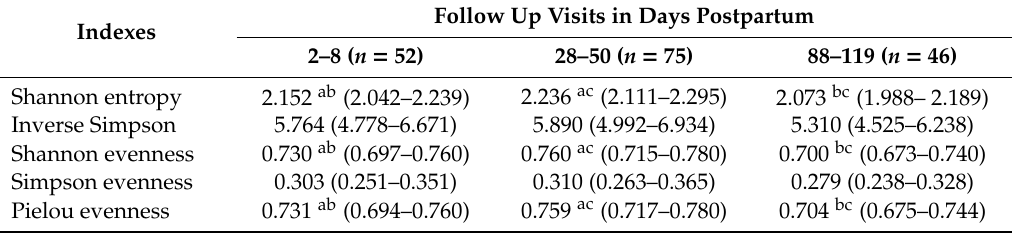
Table 4. Variation in HMO diversity and evenness indexes among women from Brazilian cohort. Rio de Janeiro, Brazil.